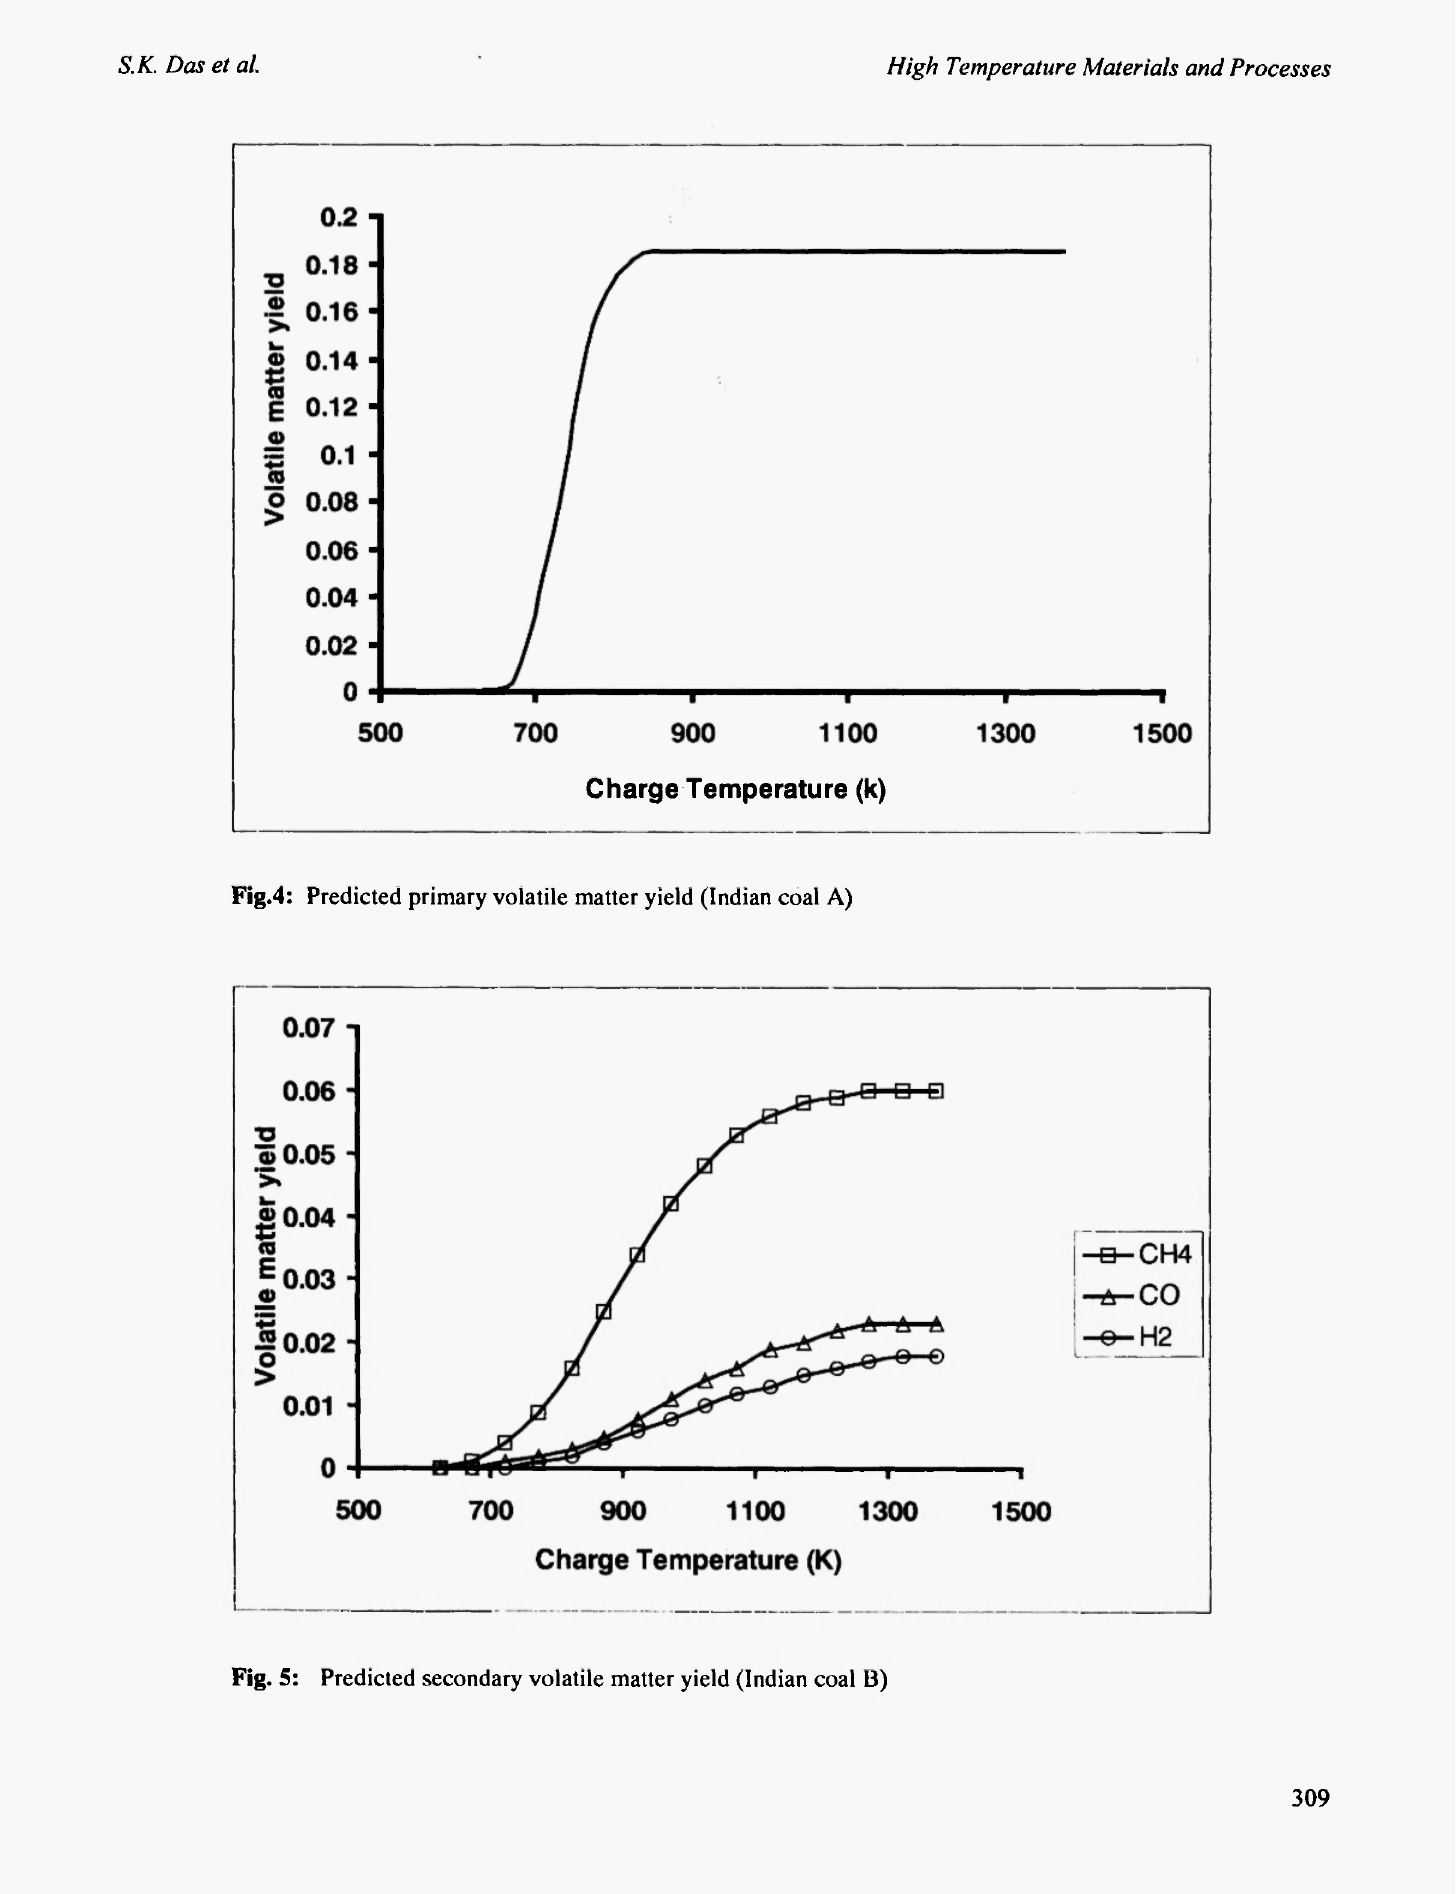
Fig. 5: Predicted secondary volatile matter yield (Indian coal